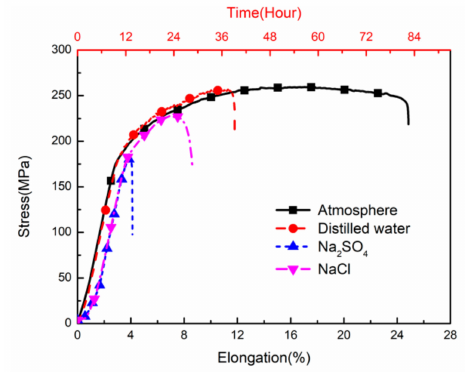
Figure 4. The stress vs. elongation plots of AM50Gd magnesium alloy at a strain rate 1.0 × 10 − 6 under di ff erent environmental